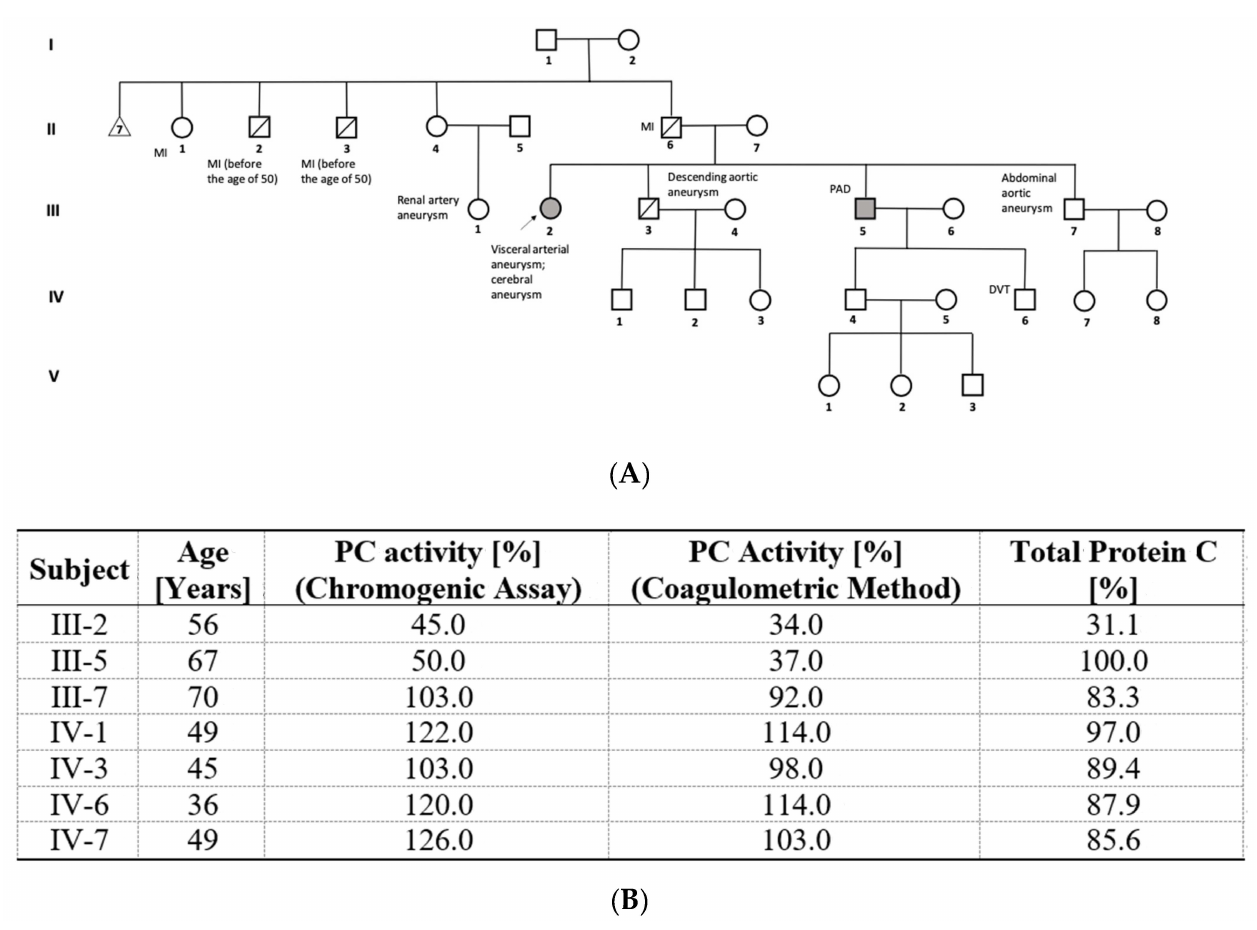
Figure 1. ( A ): pedigree of patient with novel c.401-1G>A PROC gene splice site mutation. The mutation carriers marked with grey and the proband indicated with an arrow. DVT denotes deep vein thrombosis; PAD, peripheral arterial disease; MI, myocardial infarction. ( B ): demographic and laboratory data for the subjects available for genetic and biochemical analyses. The reference ranges: PC activity, 70–140%; total protein C,